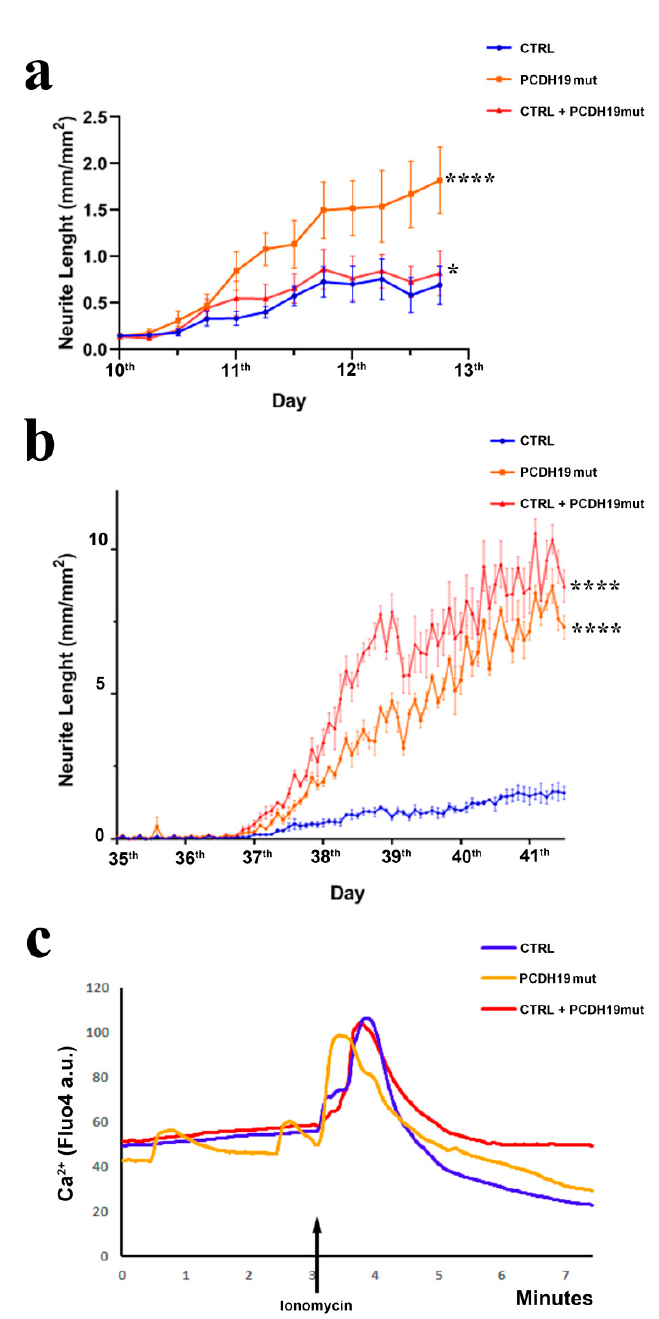
Figure 4. Morpho-functional phenotype of neurons derived from CTRL, PCDH19mut and mixed iPSCs. ( a ) Graph of live cell imaging assay of neurite length from the 10th to 13th day in CTRL, patient, and mixed iPSC-derived cortical neurons. Data are presented as mean ± SEM, n = 3. * p < 0.05, **** p < 0.0001, according to ordinary one-way ANOVA parametric test; ( b ) Neurite length analyses in CTRL, PCDH19mut and mixed cortical neurons showing neurite length from the 35th to 41st day. Data are presented as mean ± SEM, n = 3. **** p < 0.0001, according to ordinary one-way ANOVA parametric test; ( c ) Graphical representation of intracellular Ca 2+ flux in CTRL, PCDH19mut and mixed cortical neurons, before (basal level), following stimulation with 20 μ M ionomycin (at 3 min, as indicated by the black arrow) and following addition of EGTA to the medium (3 ′ 30 ′ ’); four biological replicates were performed ( n = 4) and, for each replicate, 10 cells were analyzed.